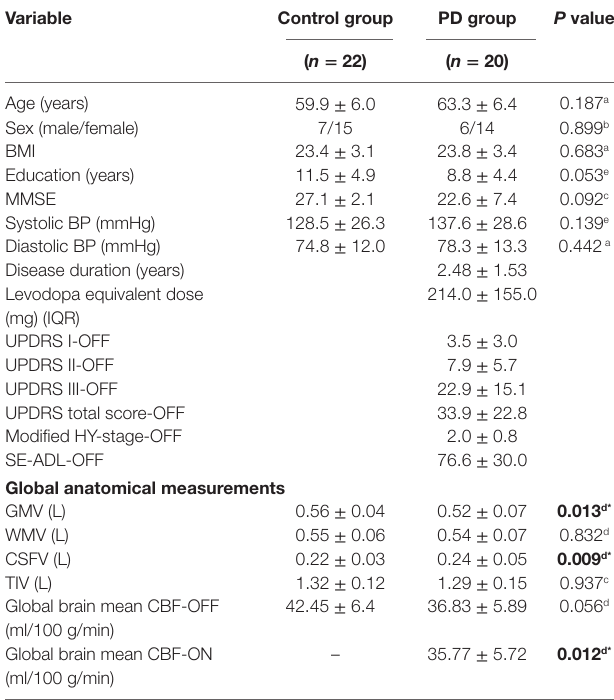
TaBle 1 | Comparison of demographic, clinical, autonomic variables, and global anatomical measurements between the healthy controls and PD